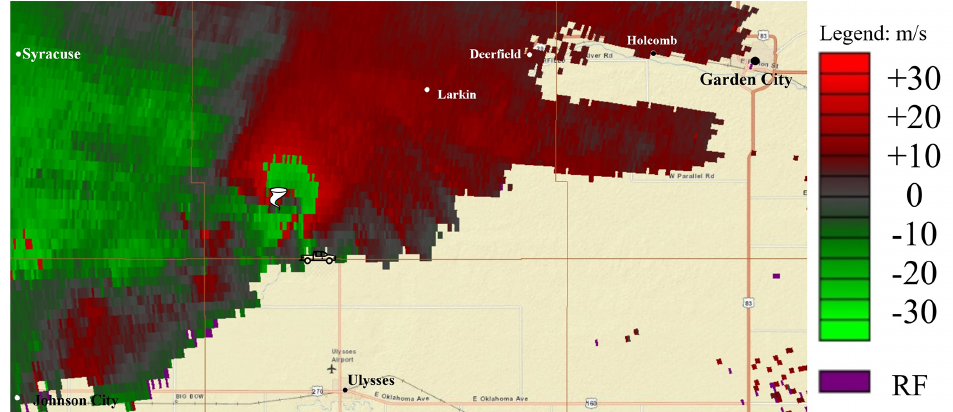
Figure B2. KDDC (Dodge City, KS) radial velocity measurement at 22 May 2020, 00:17UTC, with elevation of the scan = 2590ft (790m) (lowest possible base scan). The tornado location is indicated via the tornado icon and the storm-chaser region of intercept via the truck